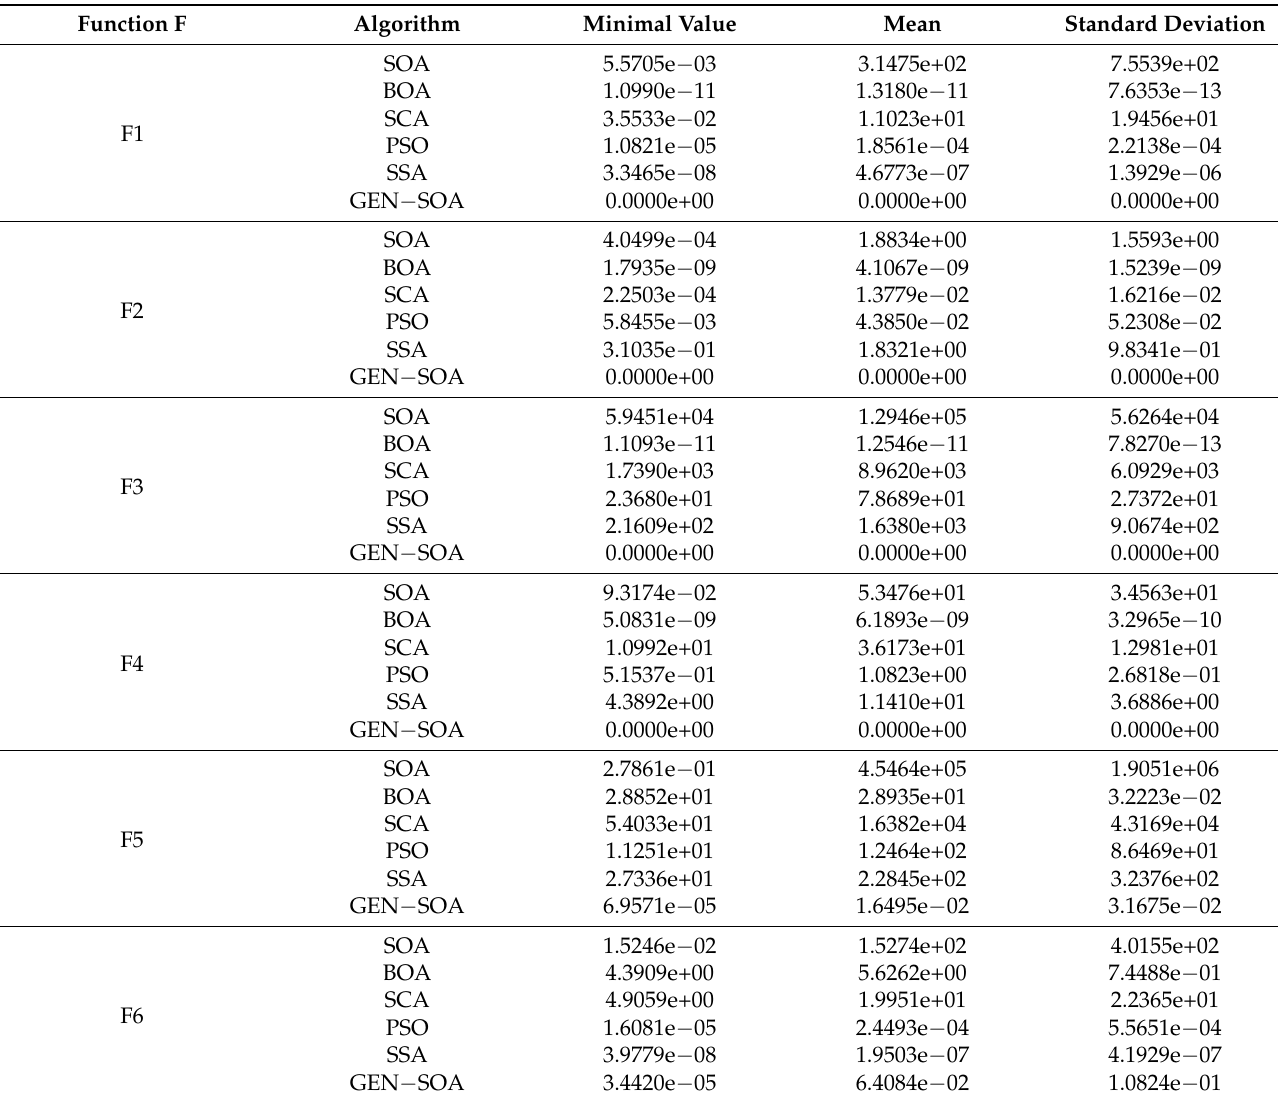
Table 2. A comparison of the results of different algorithm